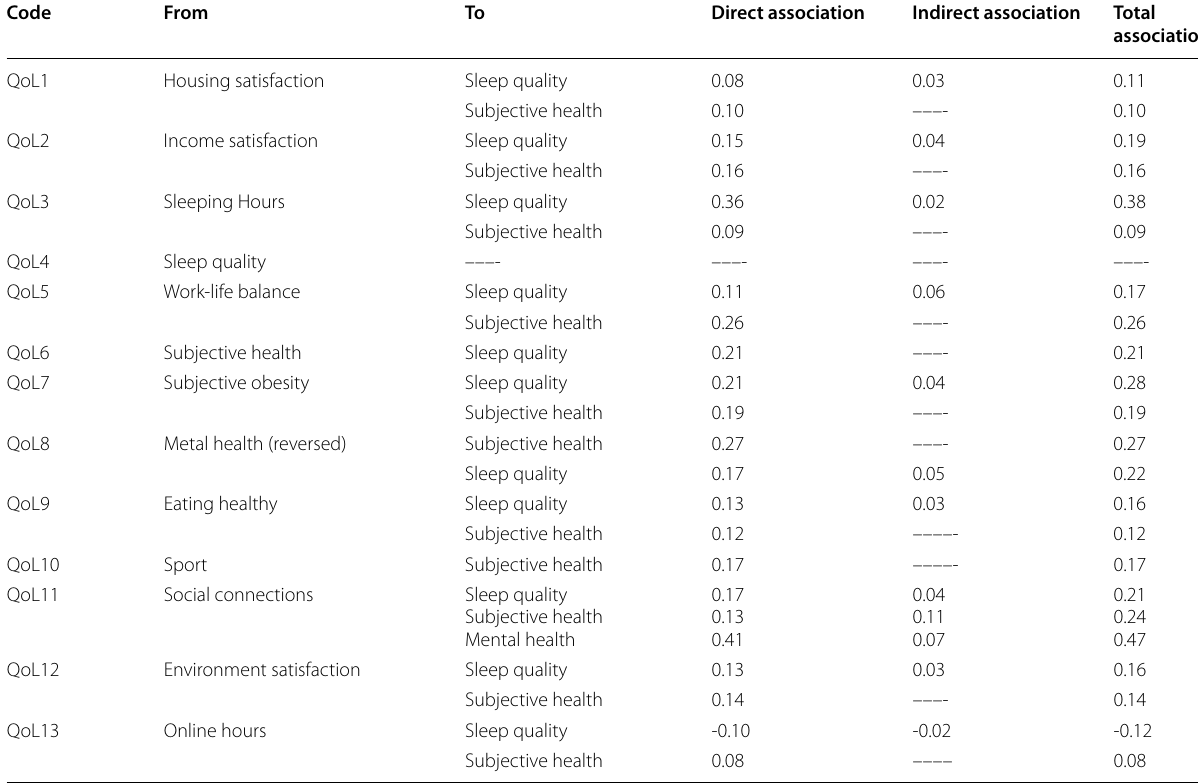
Table 7 Type of effects